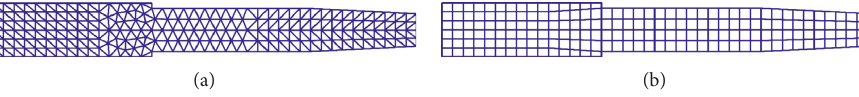
Figure 34: Domain discretization using triangular and quadrilateral